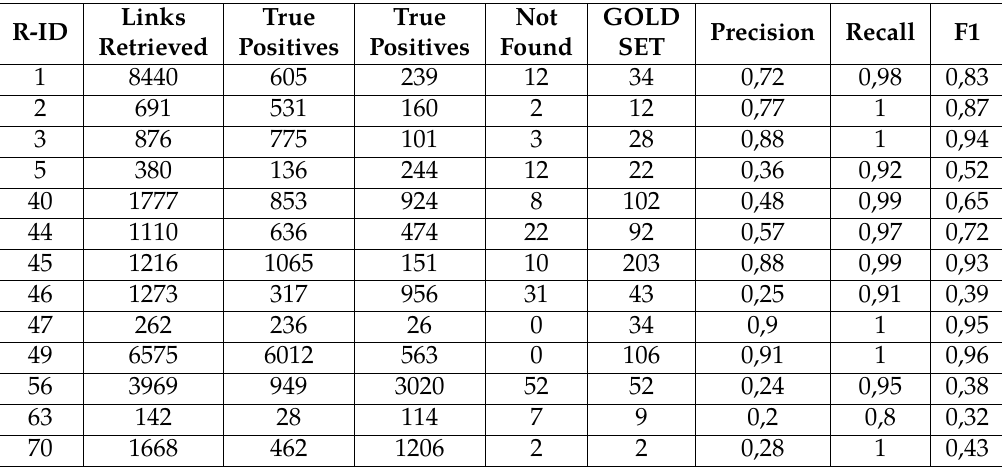
Table 8: FGTHunter results for OSCAR